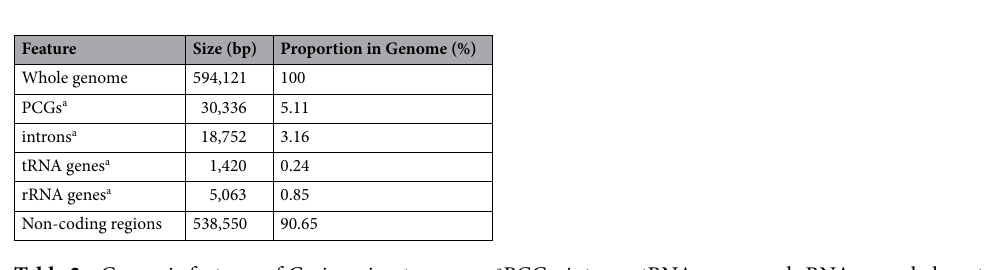
Table 2. Genomic features of G. sinensis mt genome. a PCGs, introns, tRNA genes, and rRNA genes belong to coding